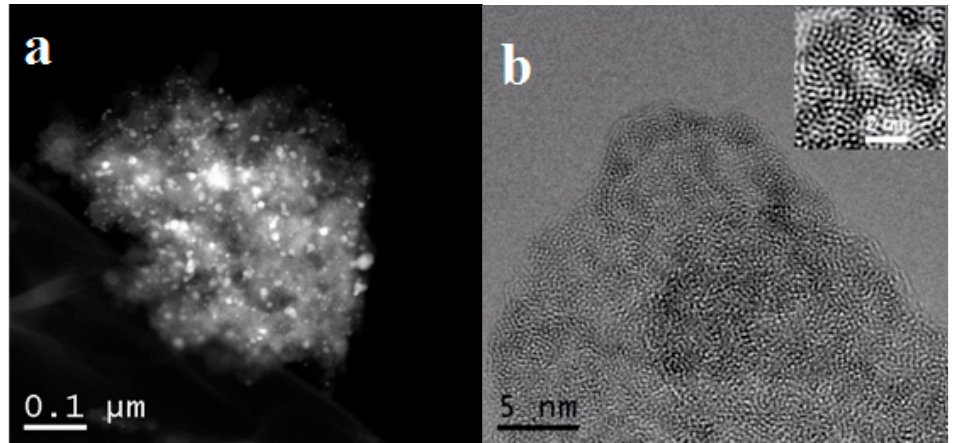
Figure 8. STEM-HAADF ( a ) and HRTEM ( b ), images of 5% AgPd@UiO-66 with an Ag / Pd molar ratio of 1/1.